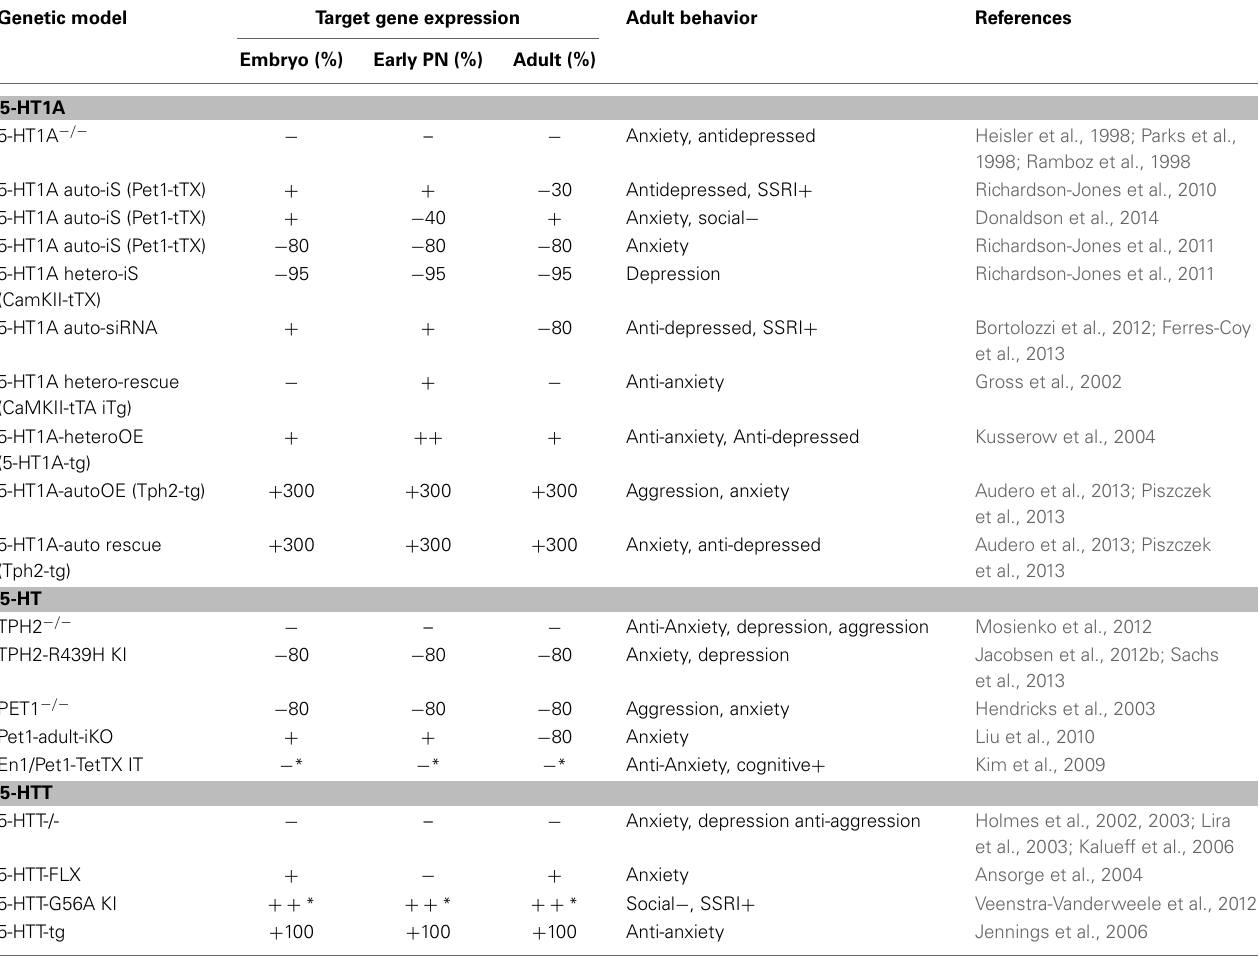
Table 1 | 5-HT genetic models